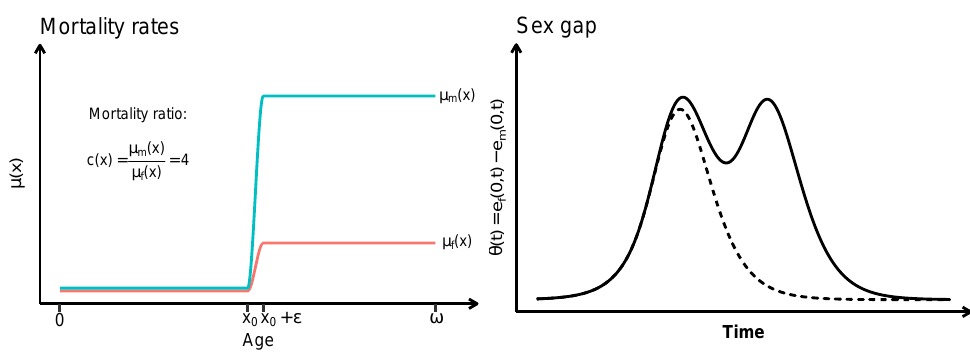
Figure 3. Mortality rates and the resulting life expectancy differential over time when the same, positive mortality improvement rate is applied to both sexes. In the right panel, the superimposed dashed line is the sex gap had the life expectancy calculation been truncated at x 0 . The curves are calculated using µ ( x ) = µ when x ∈ [ 0, x 0 ) and µ ( x ) = µδ when x ∈ ( x 0 + ε , ω ] with µ = e − 1 , x 0 = 60, δ = 50, ε = 5, and ω = 120. Continuity between x 0 and x 0 + ε is achieved by quadratic interpolation as in (19). The means of interpolation is not important for the calculation; using any C 2 -interpolating curve or applying a bump function to make µ ( x ) smooth and continuous yields virtually the same